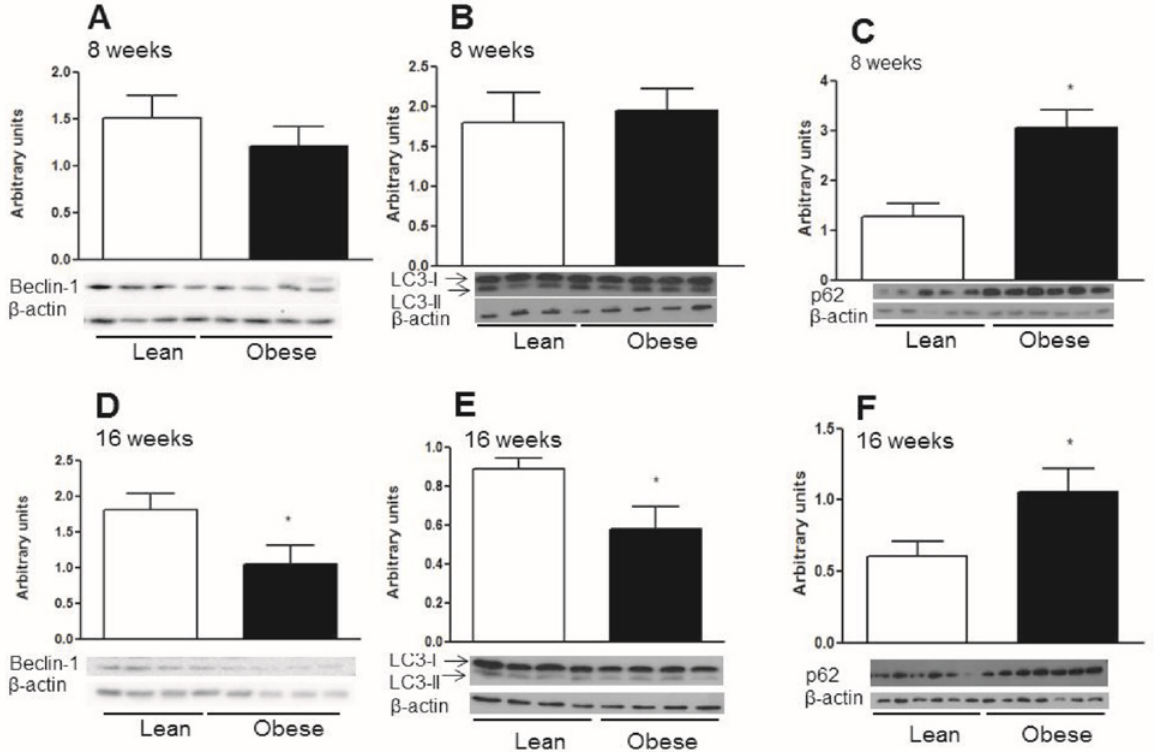
Fig 3. The contents of the autophagic proteins in the hypothalamus from diet induced obese mice with 8 and 16 weeks of treatment. A. Western- blotting shows the Beclin-1 to β -actin ratio in the hypothalamus of obese mice with 8 weeks on a HFD. B. Western-blotting shows LC3-II to β -actin ratio in the hypothalamus of obese mice with 8 weeks on a HFD. C. p62 content in the hypothalamus of obese mice with 8 weeks on a HFD. D. Beclin-1 content in the hypothalamus of obese mice with 16 weeks on a HFD. E. LC3-II to β -actin ratio in the hypothalamus of obese mice with 16 weeks on a HFD. F. p62 content in the hypothalamus of obese mice with 16 weeks on a HFD. Values are shown as mean ± SEM. * P < 0.05; n = 4 – 7 animals per